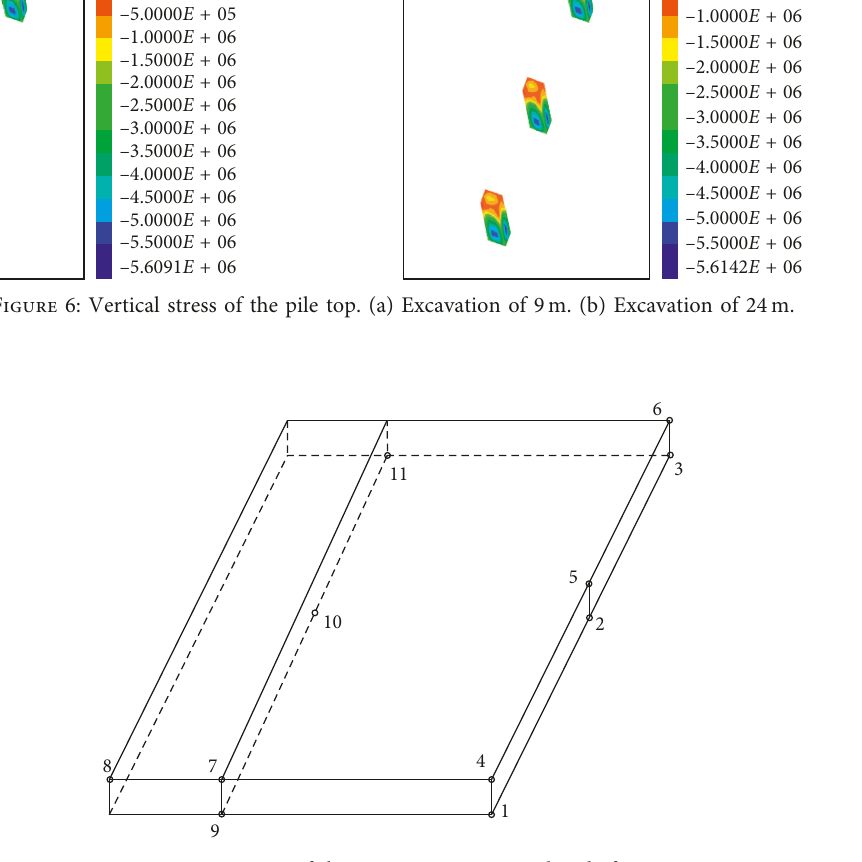
Figure 7: Layout of the measuring point in the